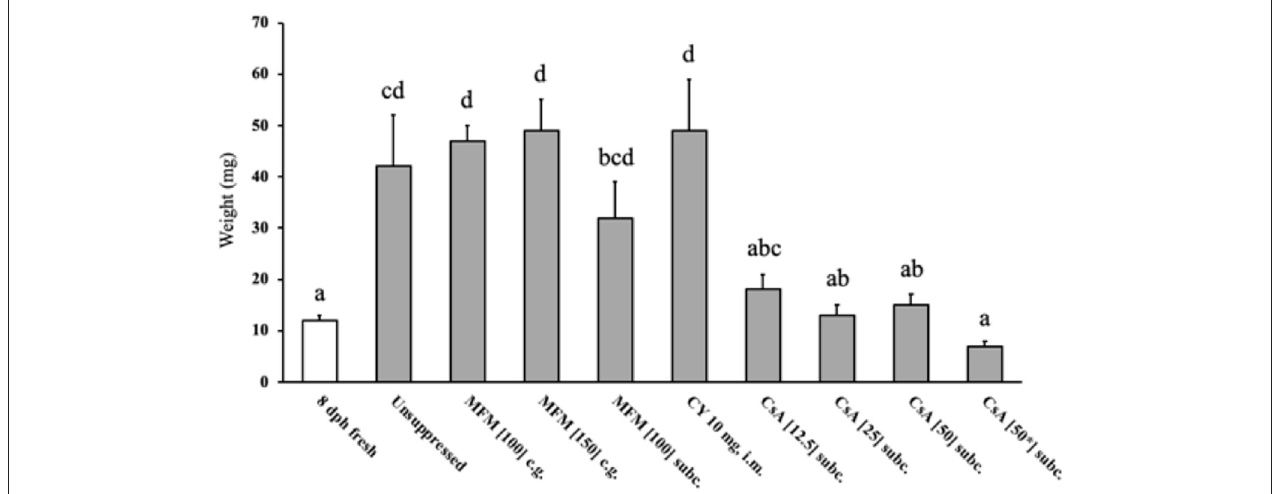
FIGURE 2 | Weight of ovarian transplants 14 days post-surgery. The 8 dph fresh tissue (open bar) represents the size of the two pieces of ovarian grafts when transplantation occurred, all other weights (grey bars) indicate the transplant size after the 14 days post-surgery. The transplants within birds treated with CsA did not increase in weight during the 14 days, whereas the unsuppressed, MFM and CY treated birds saw their ovaries significantly increase in weight. * Indicates the treatment where 50 mg/kg/day of cyclosporin A was started pre-surgery. Data are means ± SEM of n = 3 to 5. Statistics: one-way ANOVA followed by a post-hoc , P ≤ 0.05. a − d Means with no common superscript differ significantly. dph, days posthatch; MFM, mycophenolate mofetil; CY, cyclophosphamide; CsA, cyclosporin A; CG, crop gavage; SC, subcutaneous injection; IM, intramuscular injection.